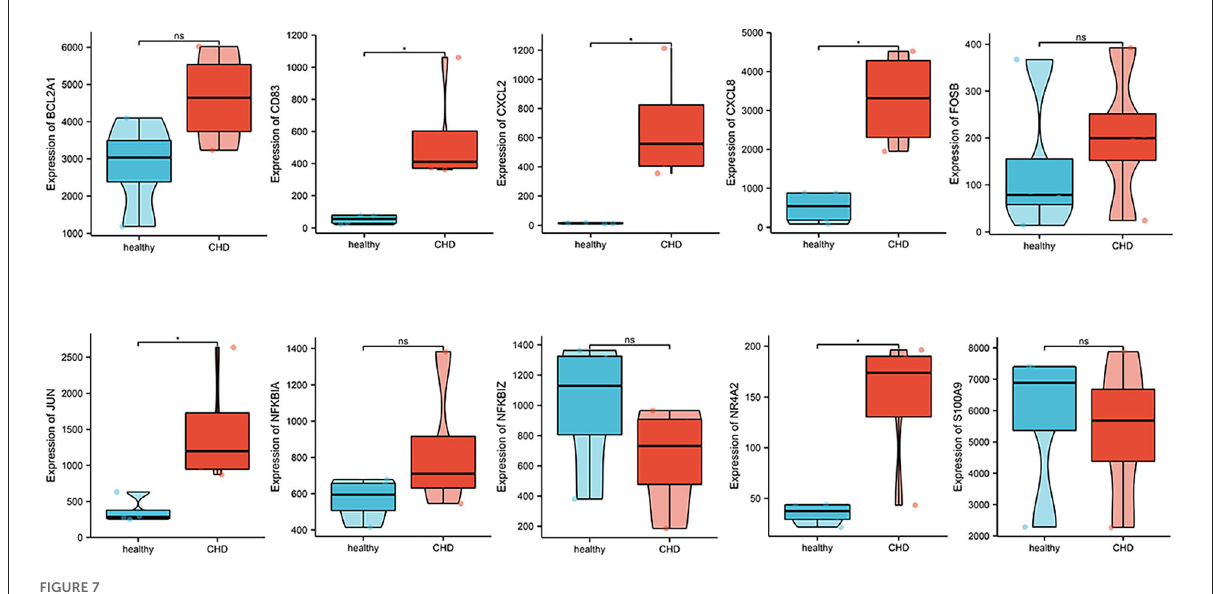
FIGURE7 The validation of ten hub genes in the GSE19339